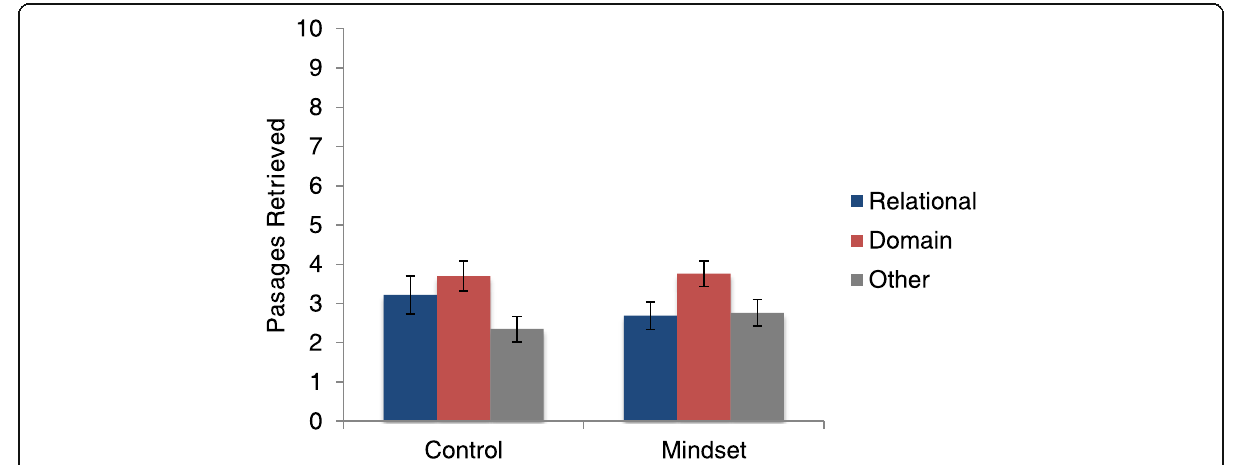
Fig. 1 Means (and standard errors) for the number of passages retrieved in experiment